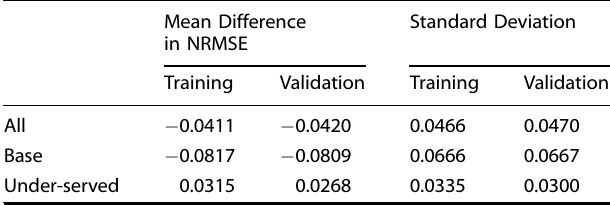
Fig. 6 Effect of remediation. NRMSE is shown for the whole dataset, the base group and the under-served group, before and after remediation, over n = 10 trials, on training and validation data. Performance was worse on the under-served group, and this improved after rebalancing. However, there was a high cost in base group performance. See differences in Table 3. The boxplots show the median (centre line), 25th and 75th centiles (box), 1.5 times the interquartile range (whiskers), and outliers (diamonds). Table 3. Difference in Normalised Root Mean Square Error (NRMSE) before and after rebalancing.